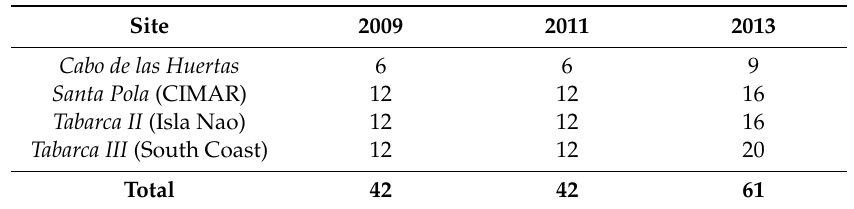
Table 1. Number of visual surveys conducted per year (2009–2013) at a given site within and surrounding the Tabarca marine protected